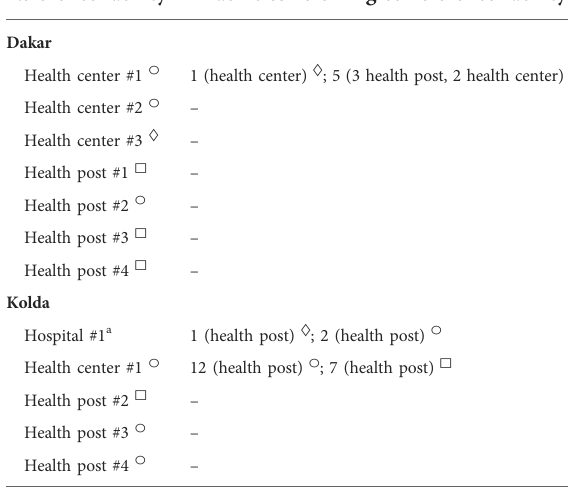
TABLE 3 Referral networks for dif fi cult